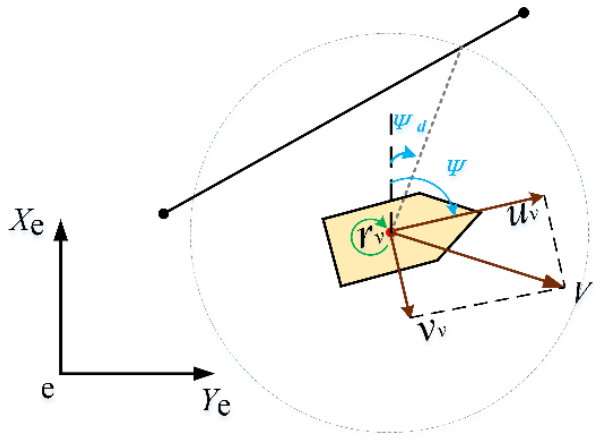
Figure 1. The ship motion mathematical model.